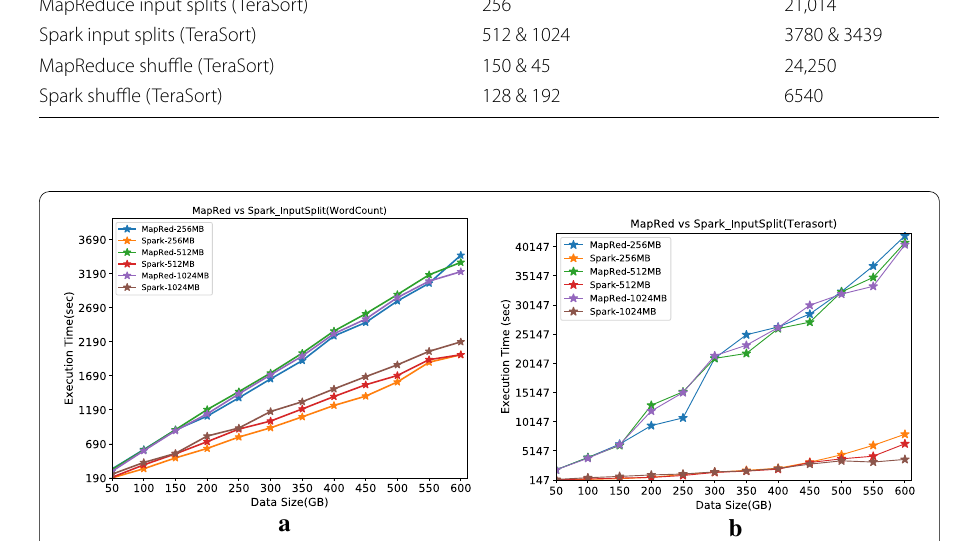
Fig. 6 The comparison of Hadoop and Spark with WordCount and TeraSort workload with varied input splits and shuffle